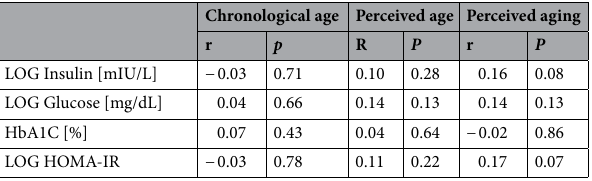
Table 3. The relationship between glycemic markers and perceived age in men (N =